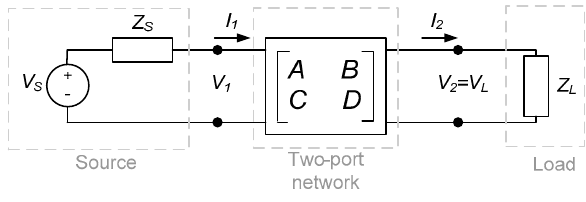
Figure 3. Two-port network model.